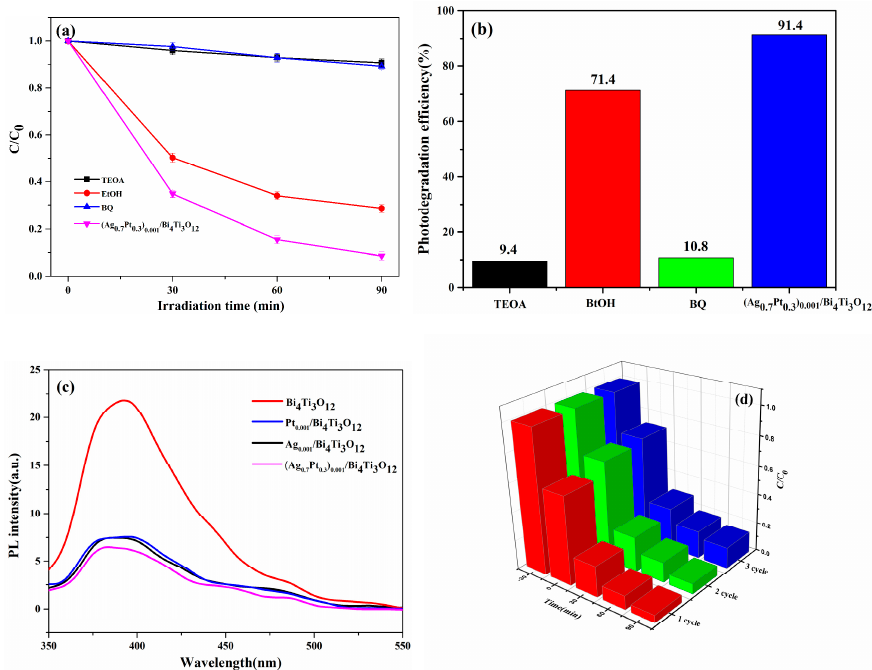
Figure 12. ( a , b ) Effects of various scavengers on the photocatalytic efficiency of (Ag 0.7 Pt 0.3 ) 0.001 / Bi 4 Ti 3 O 12 ; ( c ) photoluminescence spectra of Bi 4 Ti 3 O 12 and AgPt / Bi 4 Ti 3 O 12 ; ( d ) Cyclic photodegradation of RhB by (Ag 0.7 Pt 0.3 ) 0.001 / Bi 4 Ti 3 O 12 photocatalyst.